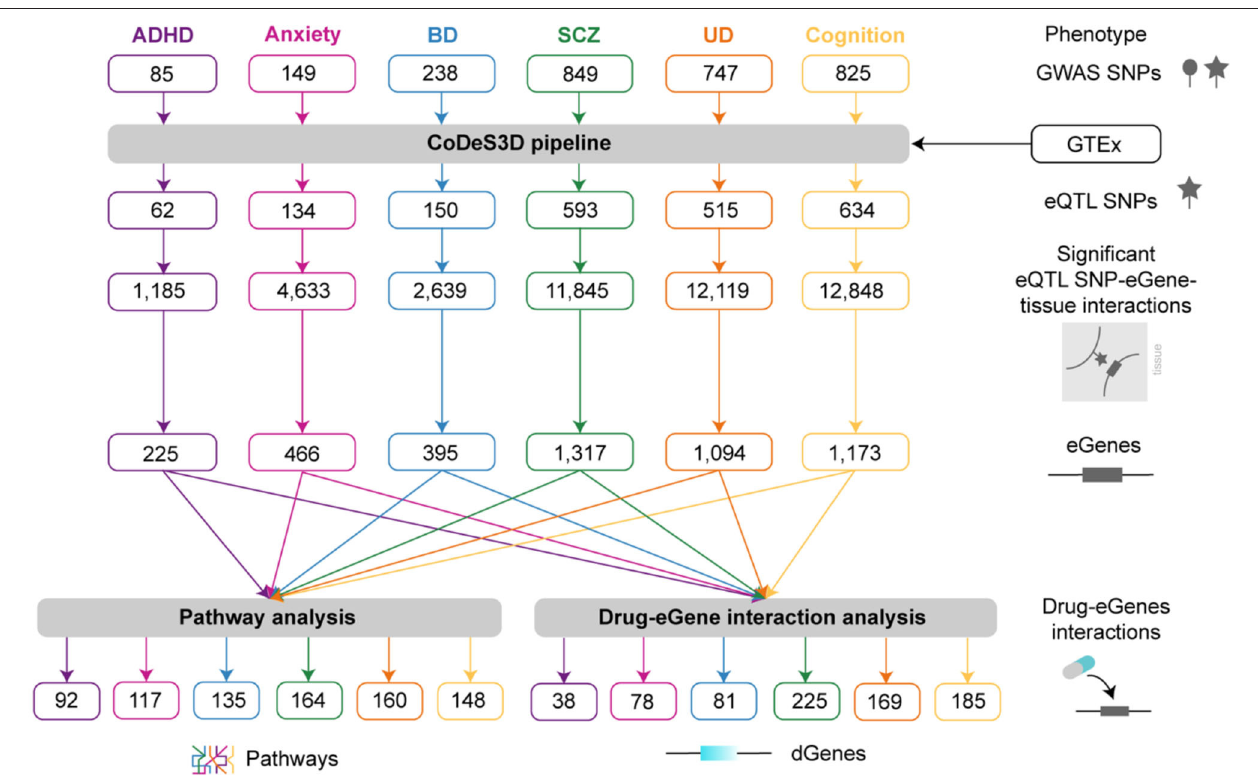
FIGURE 2 | Pipeline used to study the multimorbidities between psychiatric and cognitive phenotypes. SNPs associated with ADHD, anxiety, BD, SCZ, UD, and cognitive functioning were obtained from the GWAS Catalog and analyzed using CoDeS3D ( Supplementary Figure 1 ) to identify the genes associated with significant spatial eQTLs. Phenotype-specific lists of eQTLs are presented in Supplementary Spreadsheet 2 . Pathway analysis was used to identify pathways containing co-occurring eGenes for the different phenotypes ( Supplementary Table 5 ). Drug-eGene interaction analysis was performed to identify druggable genes ( Supplementary Spreadsheet 5